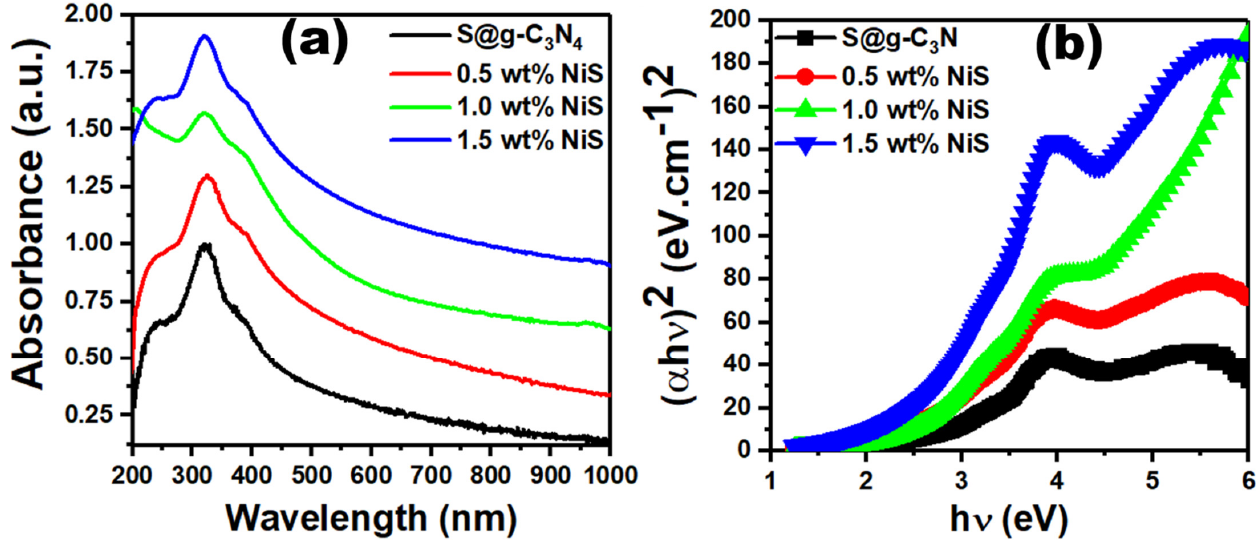
Figure 6. Graphs of ( a ) absorbance vs. wavelength and ( b ) (ahn) 2 vs. photon energy for S@g-C 3 N 4 and NiS-g-C 3 N 4 nanocomposites. and NiS-g-C 3 N 4